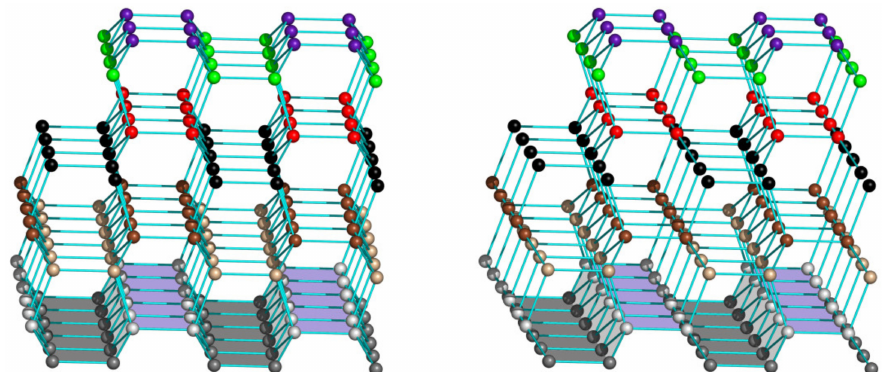
Figure 5. A stereo drawing of a piece of the same “normal” hexagonal ice (ice I h , [24]) on another underlying surface (highlighted in gray and violet–gray). This underlying surface is fitted to prism planes of this piece of ice, which are horizontal in this figure. Atoms and hydrogen bonds are shown as in Figure